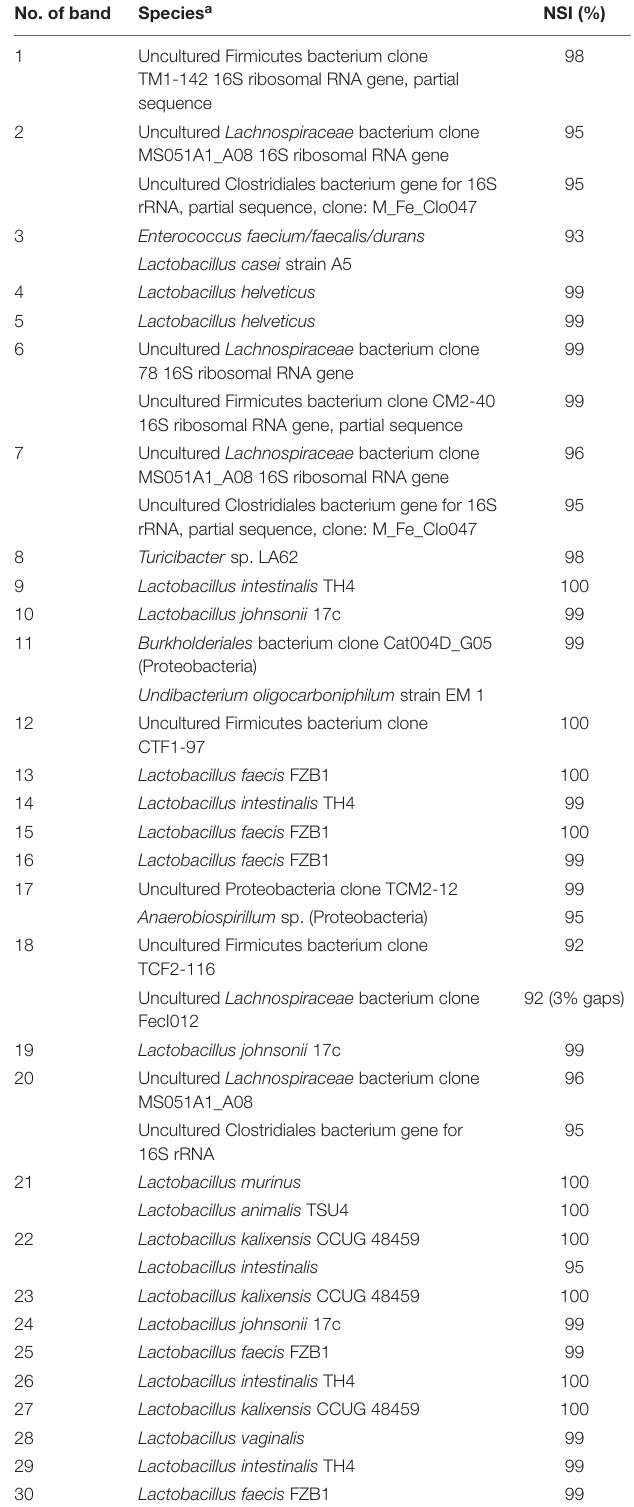
TABLE 1 | Clones with the percentage of identity to known sequences in BLAST